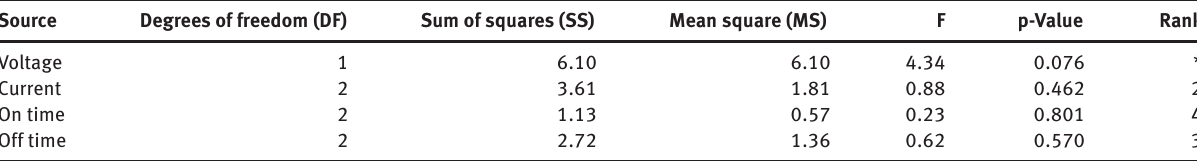
*Significant parameter. Table 8: Analysis of variance for MRR in the machining of 2024 alloy. Source